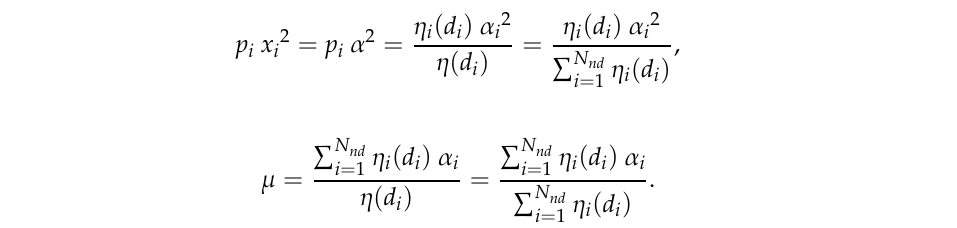
Figure 11. Variance of angle of attack as a function of azimuthal angle at TSR = 3.7 .